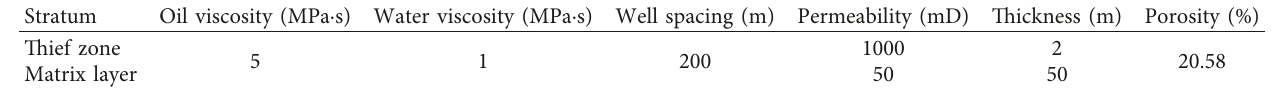
Table 2: The reservoir physical parameters.